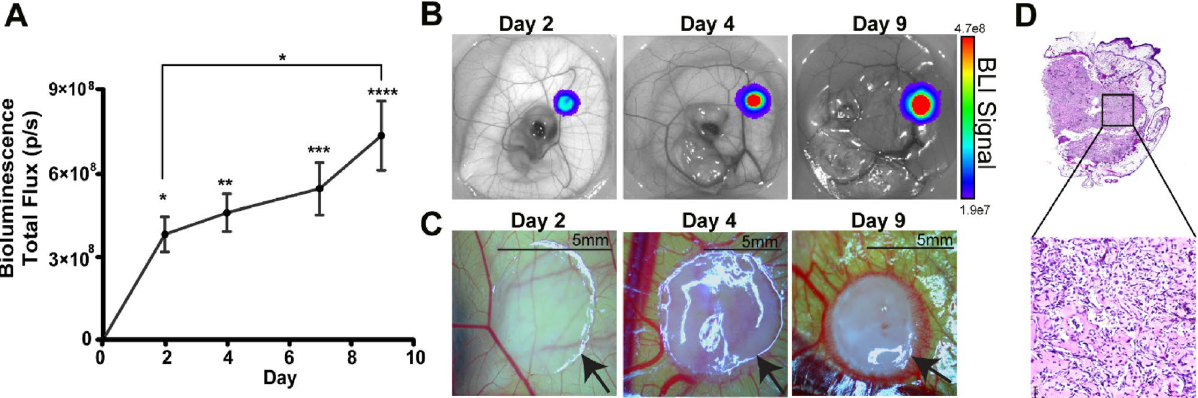
Figure 2. Engineered MDA-MB-231luc spheroids growth profile on the chick embryo chorioallantoic membrane (CAM). ( A ) Tumor spheroid growth curve of engineered MDA-MB-231luc spheroid (2.5 × 10 5 cells/ spheroid) on CAM post engrafting (n = 16). Error bars represents SEM, asterisk denotes significance, Tukey’s test. ( B ) Representative image of MDA-MB-231luc spheroid on CAM measured via IVIS. ( C ) Representative image of MDA-MB-231luc spheroid on CAM observed via light microscope. ( D ) Representative image of H/E staining of MDA-MB-231luc spheroid on